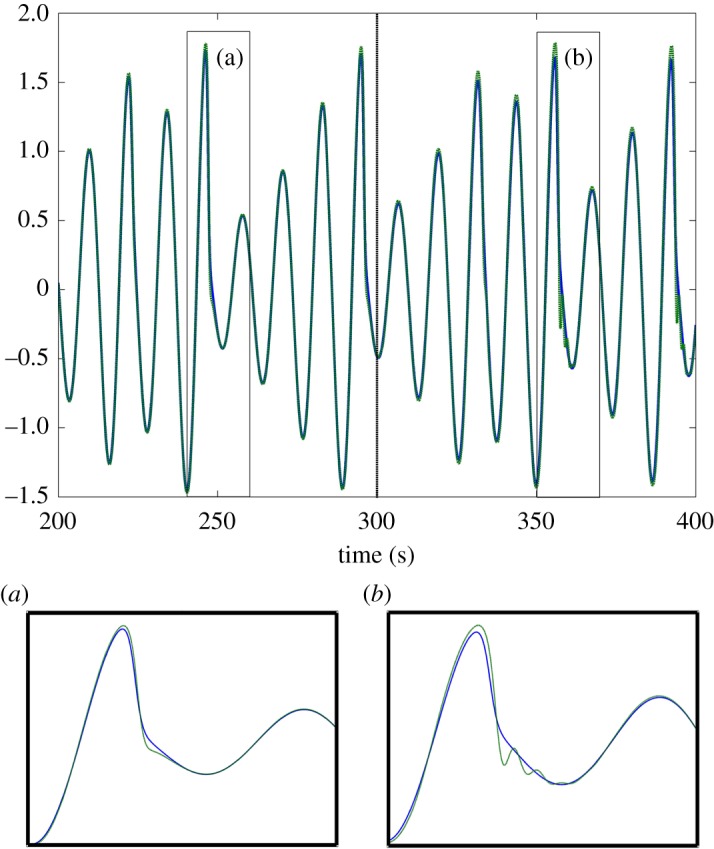
x-axis movement of the target (blue, solid line) and the end-effector of the parallel system plant with K=0.3 (green, dashed line), which must track it. τ=0.1 s before rising to 0.3 s at the 300 s point. The increase in τ causes the end-effector to oscillate more after non-sinusoidal moments of the target (cf. inset figures (a) and (b)), but does not cause a proportionate increase in lag.